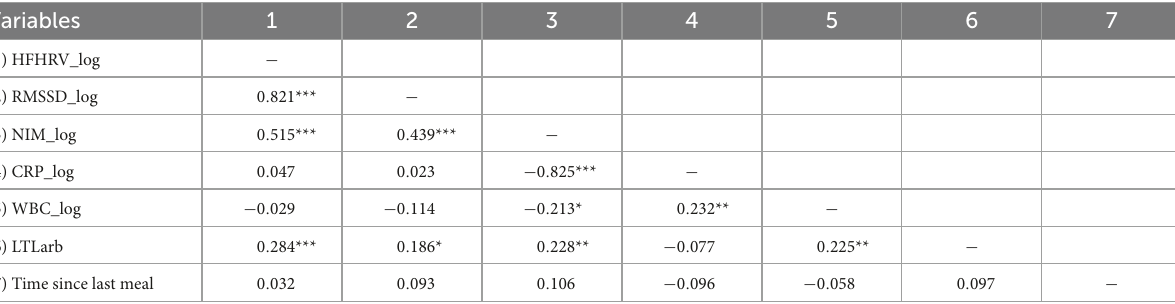
TABLE 3 Pearson correlations ( N =